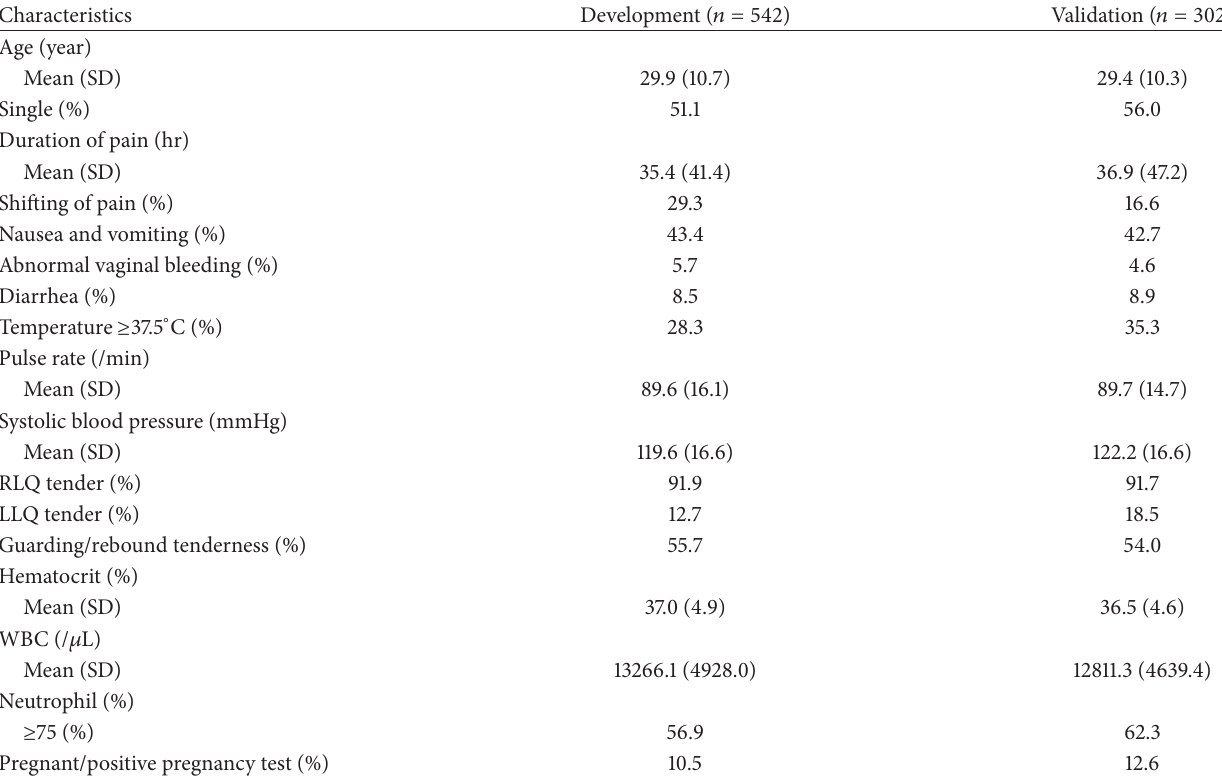
Table 2: Demographic and clinical characteristics of patients in the development data set and validation data